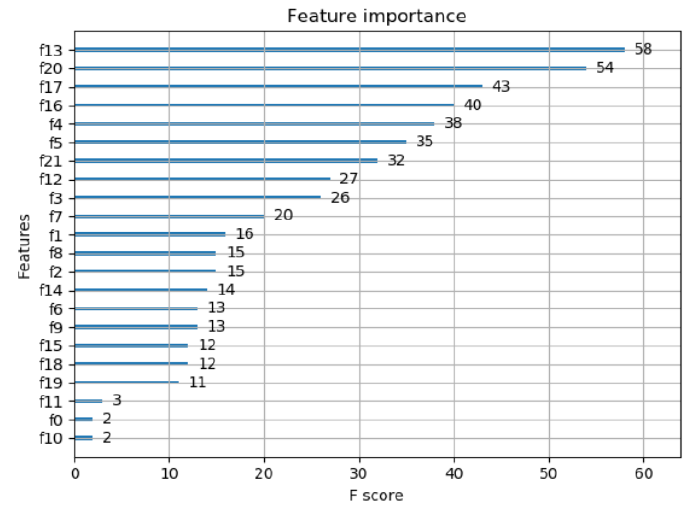
Figure 4. Feature importance.